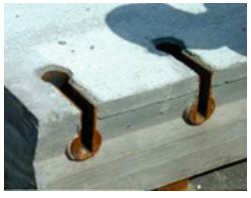
Figure 4. Kwik joint steel couplers (Tayabji et al. , 2008)